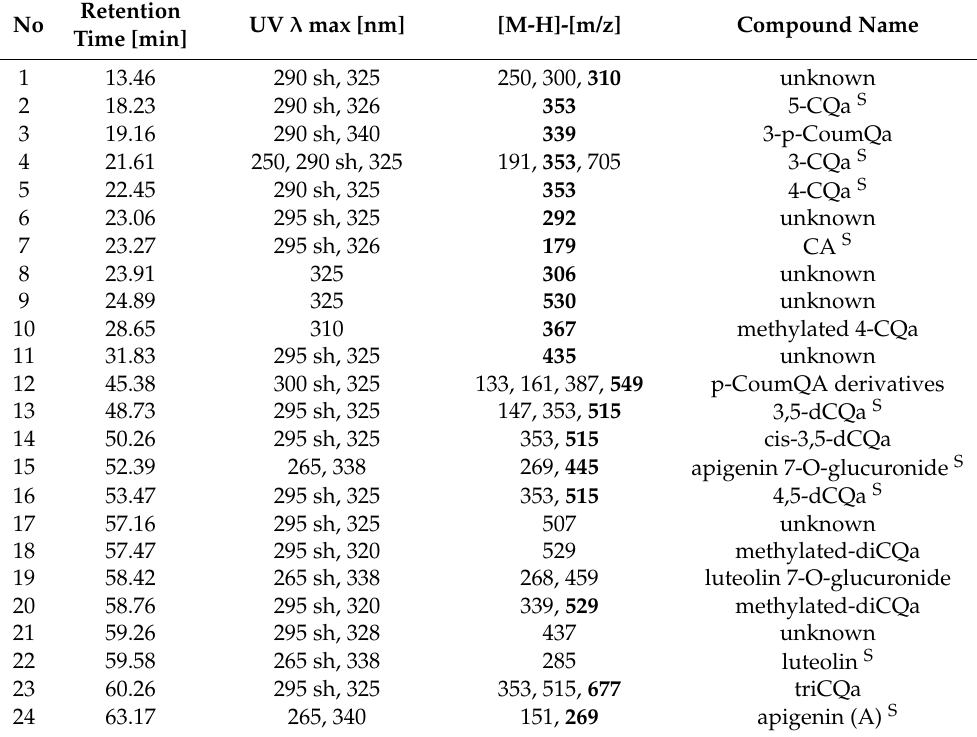
Table 2. LC-PDA-TOF/MS qualitative analysis of extracts and fractions of S. hispanica seeds.